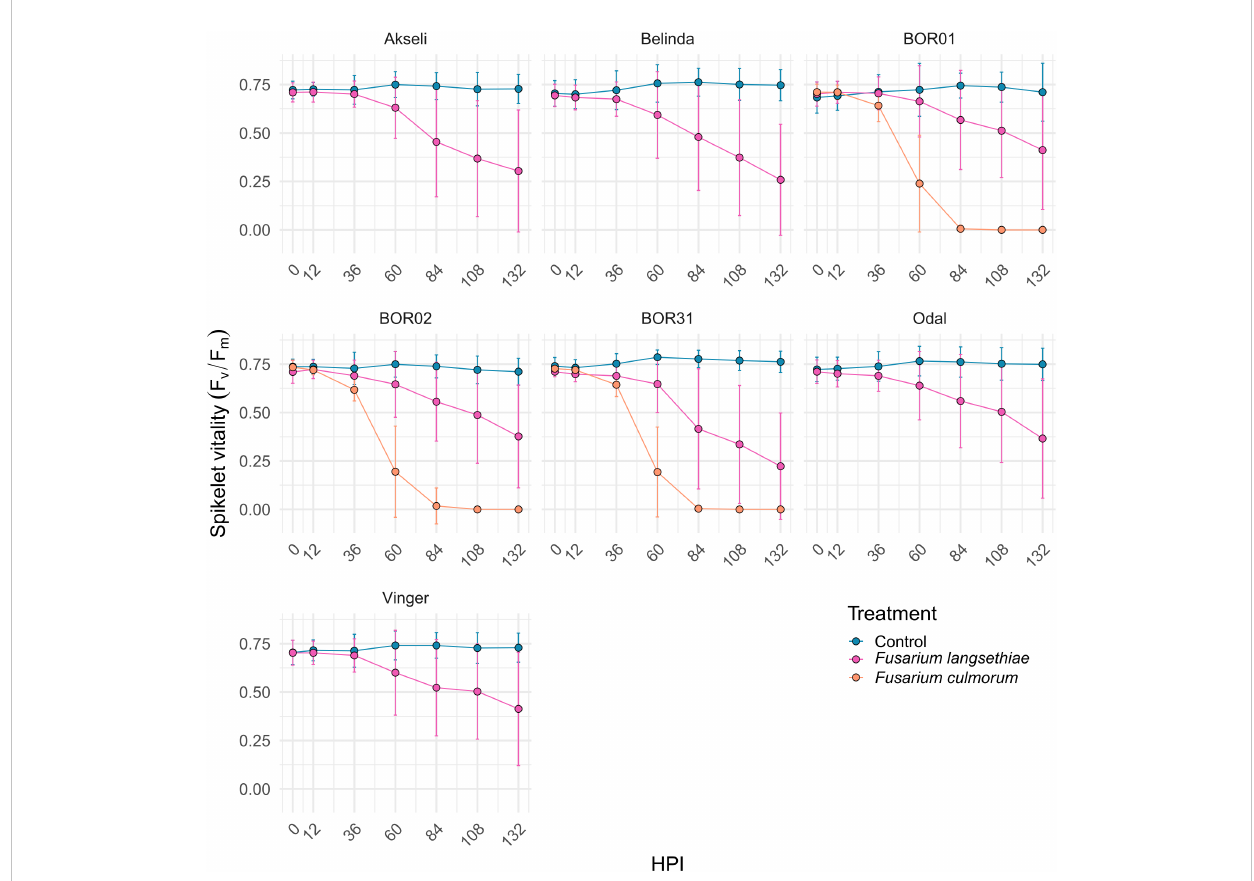
FIGURE 5 Time series of oat spikelet vitality measured by F v /F m mean values per spikelet after Fusarium spp. or control inoculation. Data are presented as mean of F v /F m values of all fl uorescent pixels per spikelet at different hours post inoculation (HPI). All oat genotypes were inoculated with control (mock) and F. langsethiae , and BOR01, BOR02, and BOR31 were inoculated in addition with F. culmorum . Blue line, vacuum control; magenta line, inoculated with F. langsethiae ; orange line, inoculated with F. culmorum . Dots represent means per treatment at each HPI measured and error bars represent standard deviation. This analysis includes combined data from two experimental batches. Each data point represents the mean of 21 – 38